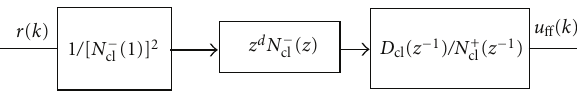
Figure 6: ZPETC block diagram.